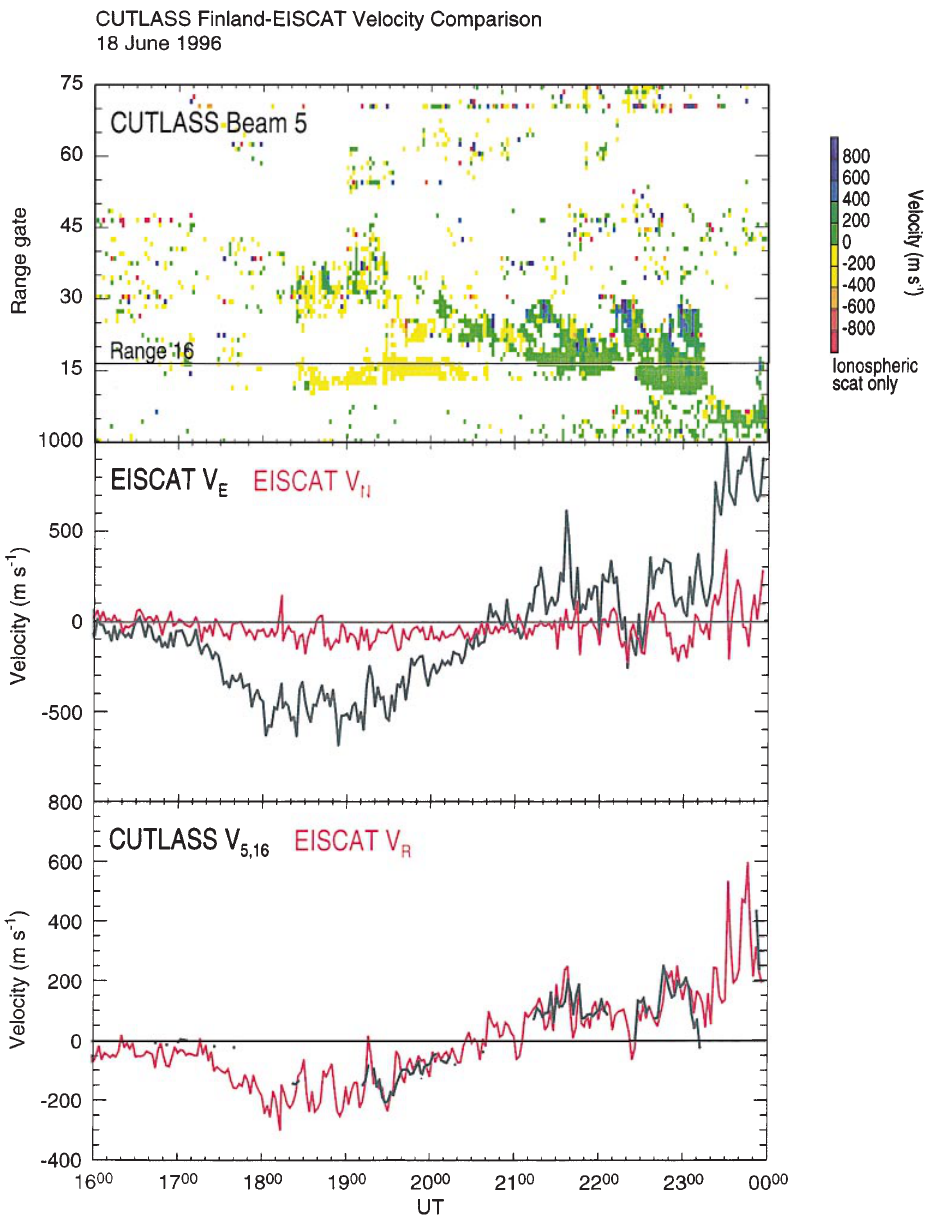
Fig. 2. EISCAT CP-1 and CUTLASS Finland velocity measurements from 1600 to 2400 UT on 18 June, 1996. The upper panel illustrates irregularity drift velocities from the Finland radar as a function of time and range gate along beam 5 (positive towards the radar). The middle panel presents time series of both field-perpendicular ion velocity components measured by EI- SCAT at the F-region tristatic altitude; the northward and eastward components ( V and N V ) are represented by the red E and black lines , respectively. The lower panel illustrates the CUT- LASS velocity spatially coinci- dent with the location of tristatic EISCAT measurements, i.e. from range gate 16 of beam 5 ( V ; black line ), and the com- 5,16 ponent of the EISCAT velocity resolved along the direction of the CUTLASS beam within range gate 16 of beam 5 ( V ; red R line ); again positive velocities indicate motion towards the